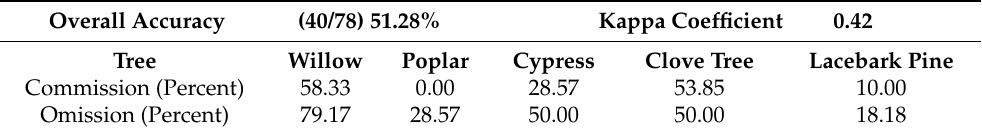
Table 7. Spectral angle classification